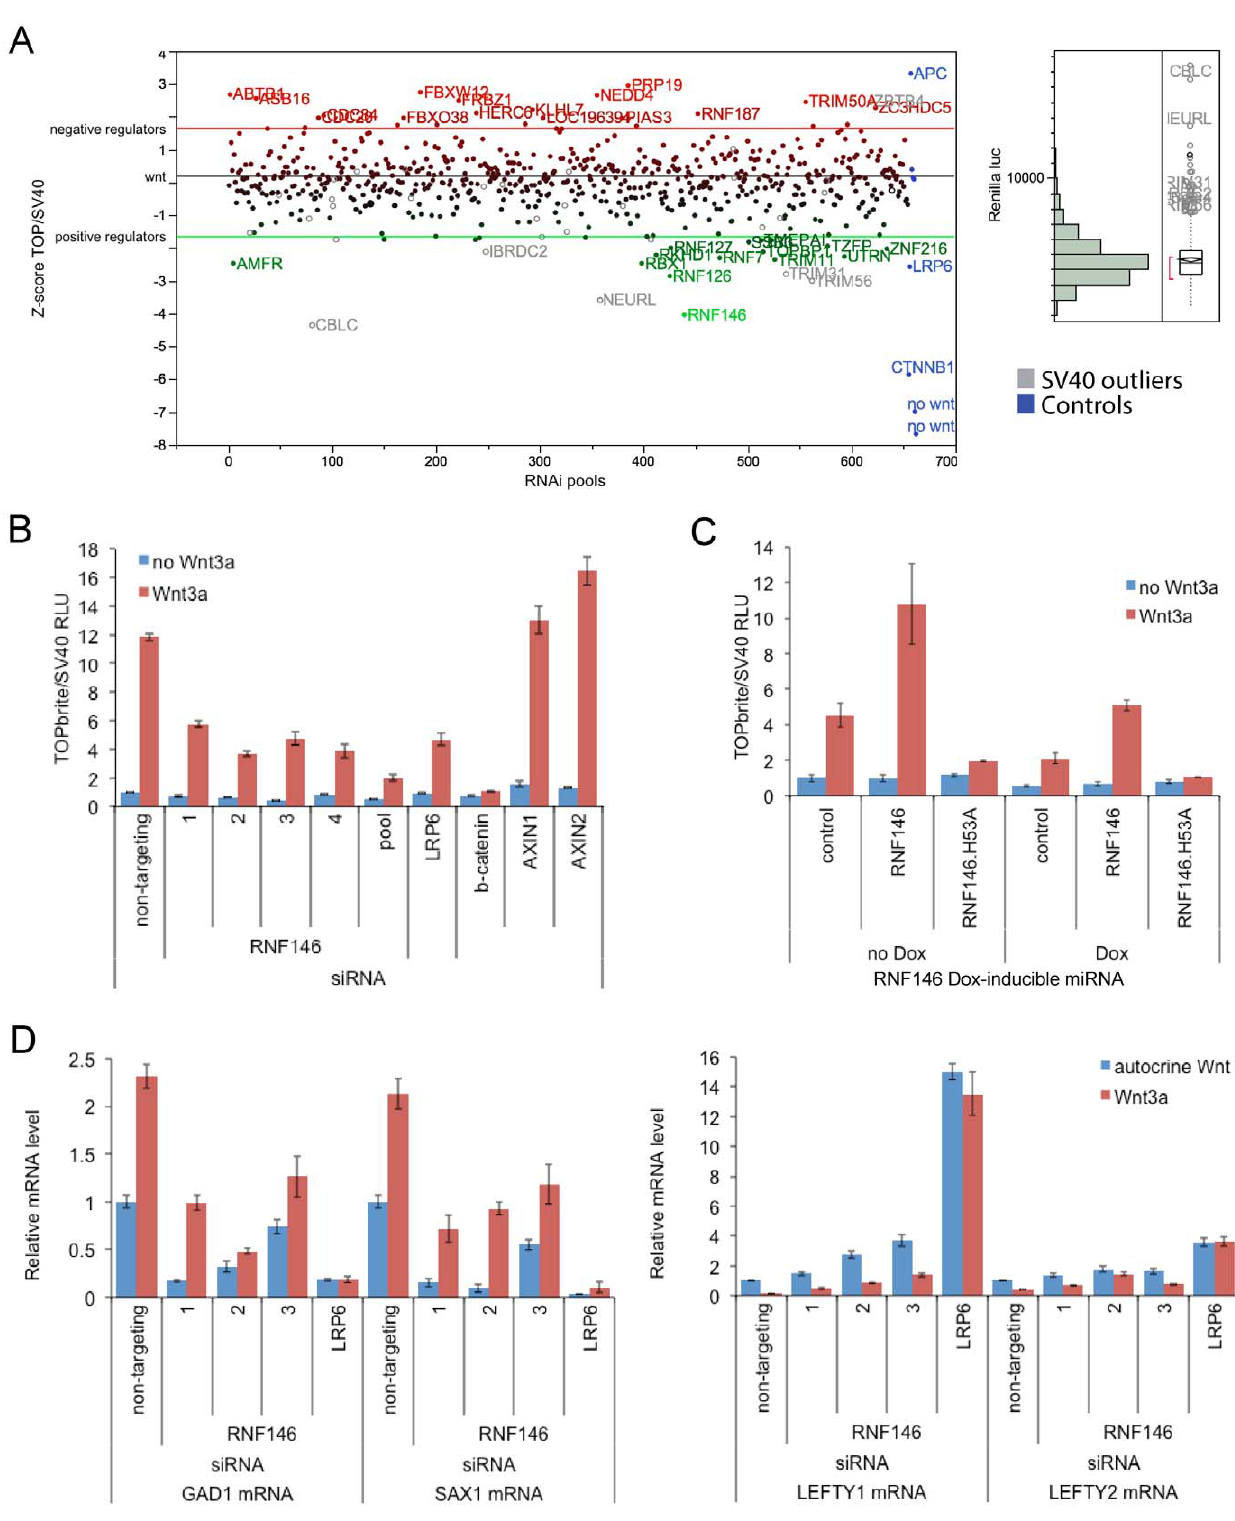
Figure 1. RNF146 positively regulates Wnt signaling. (A) Scatter plot of Z-scores for the RNAi screen of human E3 ligase siRNA pools in Wnt3a- stimulated HEK293 cells stably expressing dual luciferase reporters [17]. Z-scores on the y axis represent TOPbrite Wnt reporter values normalized to SV40 reporter values. Positively and negatively regulating siRNA pools that deviate from the Z-score cut-off lines are shown in green and red, respectively, by gene name. Control siRNAs targeting CTNNB1 ( b -catenin), LRP6 and APC, as well as control wells not induced with Wnt3a protein, are depicted in blue but were excluded from the distribution analysis. SV40 reporter values are plotted to the right, with outliers deviating from the normal distribution listed in gray on both graphs. (B) RNF146 RNAi by transient transfection of four individual and pooled siRNAs in HEK293 cells showing inhibition of the Wnt3a response (red) and lack of nonspecific effects on uninduced (blue) reporter activity. Inhibition by LRP6 and b -catenin